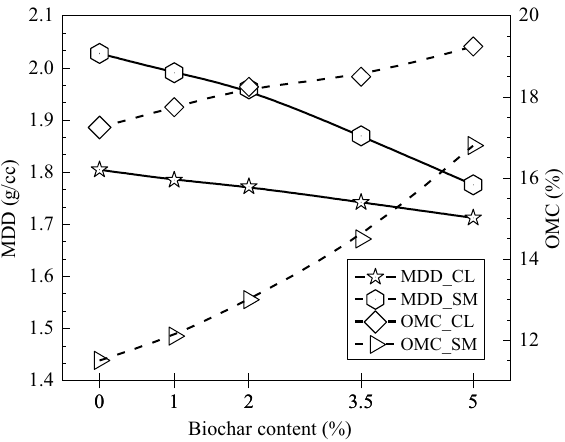
Figure 5. Variation of MDD and OMC of CL and SM soil with the increase in biochar content from 0 to 5% (w/w).